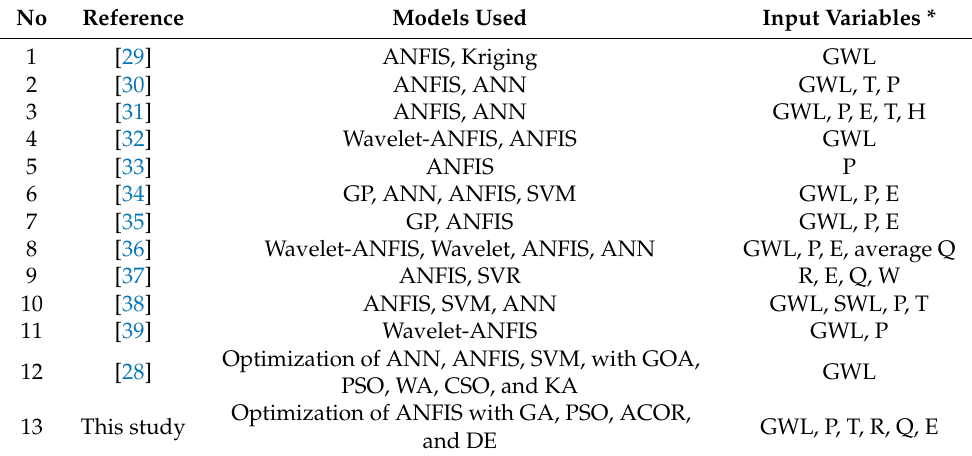
Table 1. Summary of application of ANFIS models in GWL